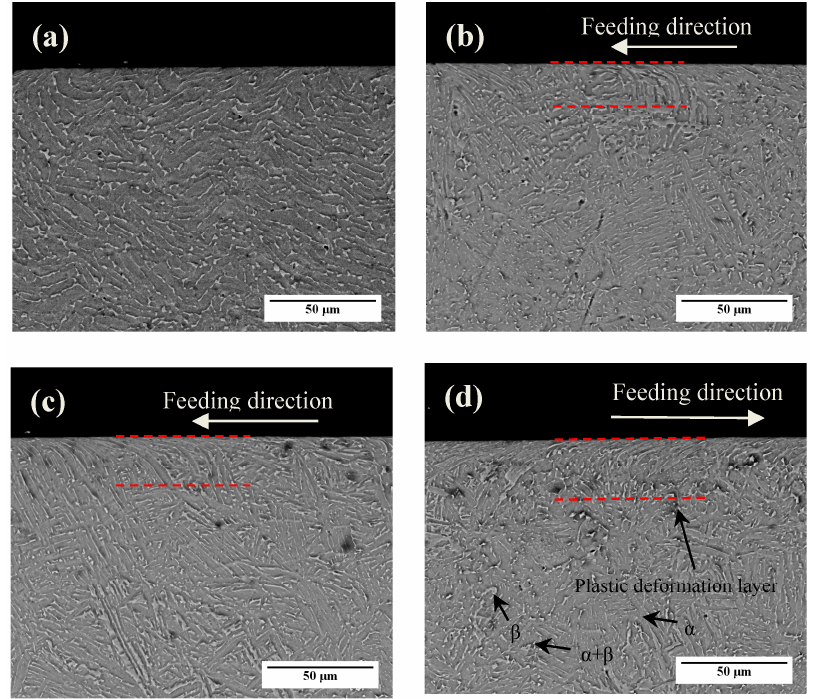
Figure 4. SEM photographs of the cross-section of HIP (hot isostatic pressing) Ti-6Al-4V samples before and after MUSR treatment: ( a ) untreated sample; ( b ) 30 kHz–600 N; ( c ) 30 kHz–750 N; ( d ) 30 kHz–900 N.